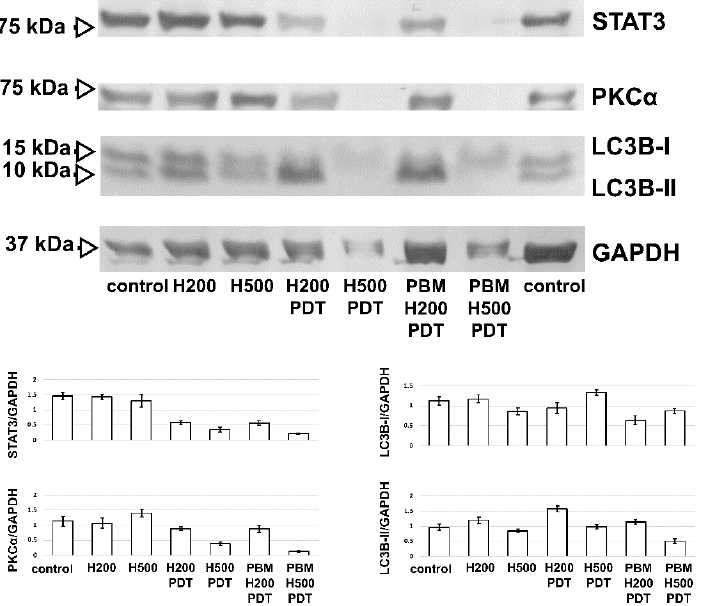
Figure 9. Western blot analysis of PKCα, STAT3 and LC3B protein levels in U87 MG cells without treatment and treated with PBM, 200 nM (H200) and 500 nM (H500) hypericin in the dark, after PBM and PDT, as shown in the images and histograms. GAPDH was used as the housing protein. The histograms show the optical densities of the detected